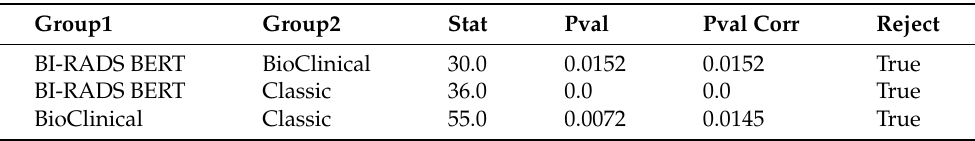
Table A12. Bonferonni-corrected McNemar test results for field extraction with no section segmenta- tion of menopausal